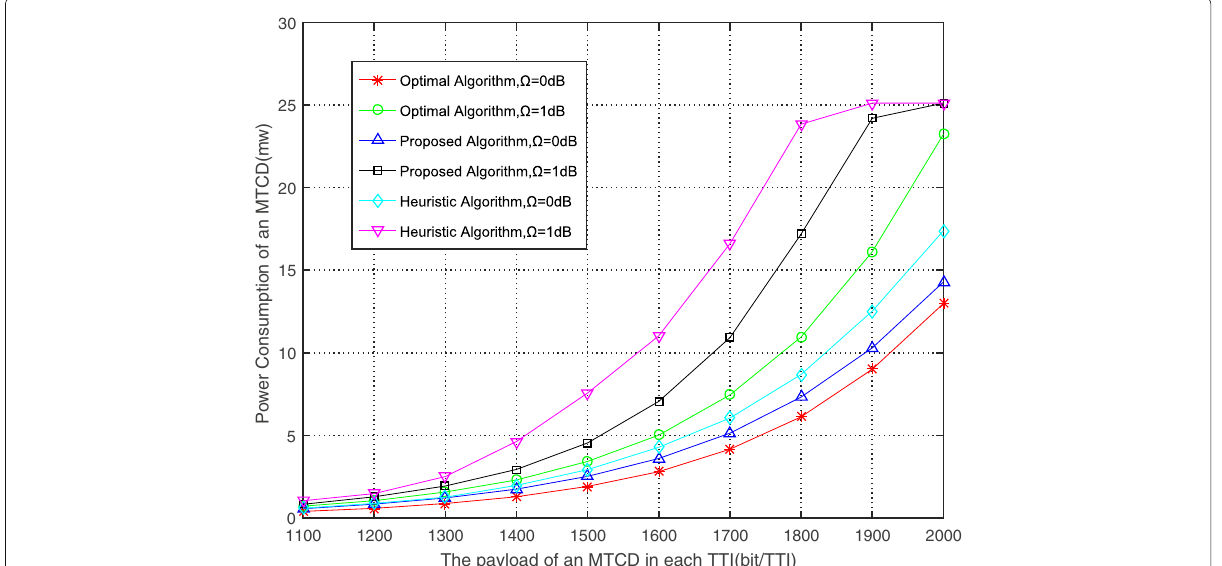
Fig. 2 The power consumption with different payloads. The MTCDs are uniformly distributed in 100-m radius of the MTCG, and the MTCG is uniformly distributed in 1000-m radius of the BS. The number of groups of MTCDs is K = 10. The other configuration parameters are = 14 dBm, P max = 24 dBm, T = 1 ms, B = 180 kHz, and B = KB = 1800 kHz P max k G k k G